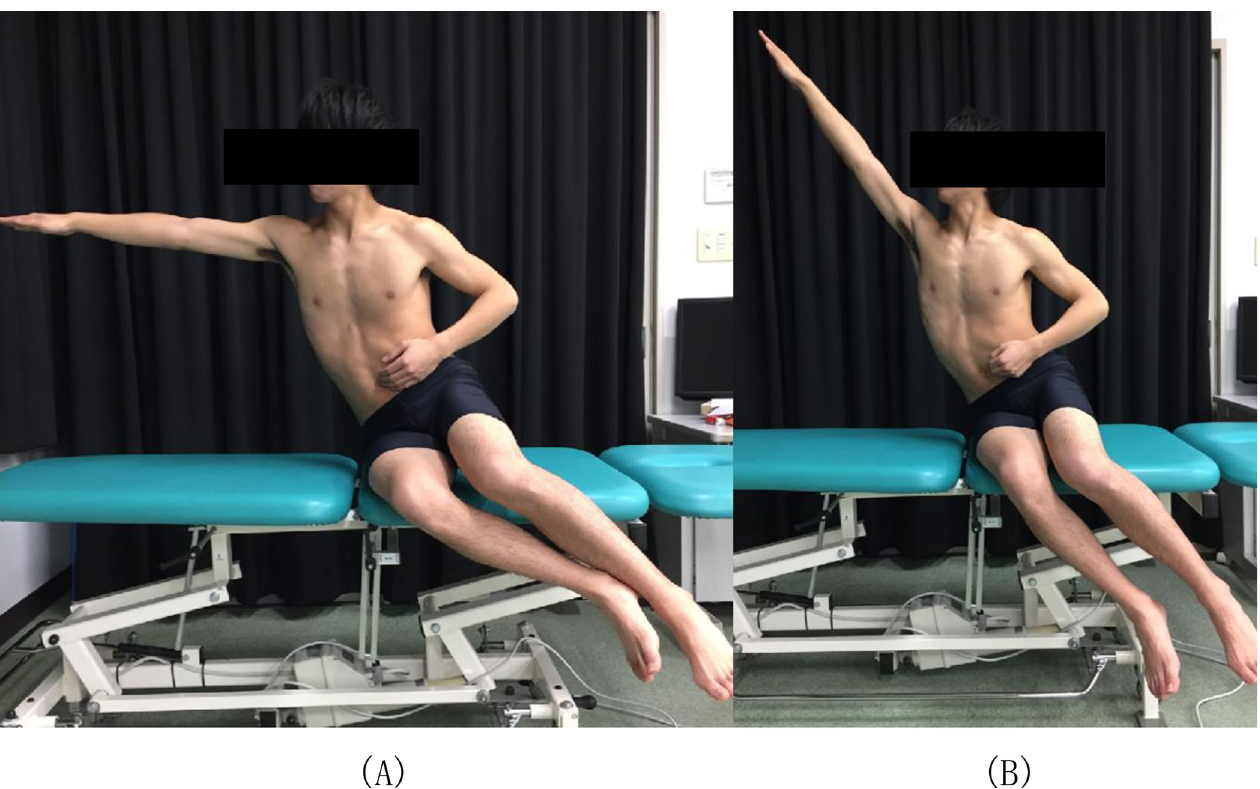
Fig 4. Trunk training. Subjects had two sets of 30 second maximal lateral reach exercises on each side (A) and the second had four sets of 15 second maximal raising trunk exercises on each side (B).